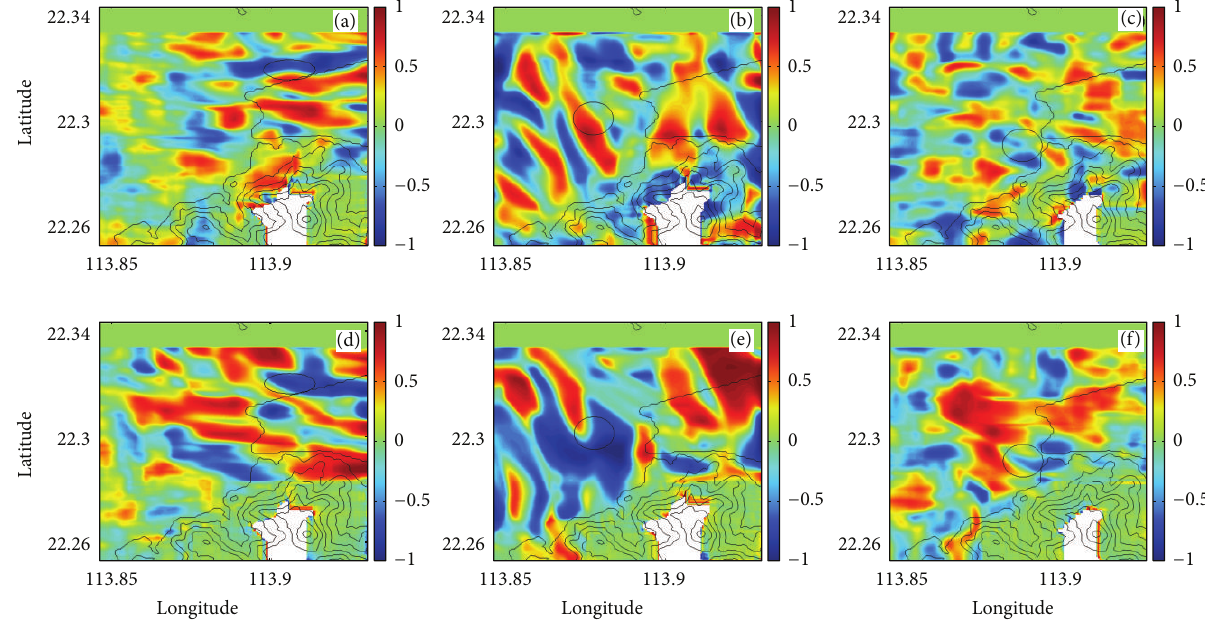
Figure 5: Localized correlation map between Figures 3 and 4. The sizes of the local regions are 1km × 1km patches. The black circles mark the mismatches discussed in Figures 3 and